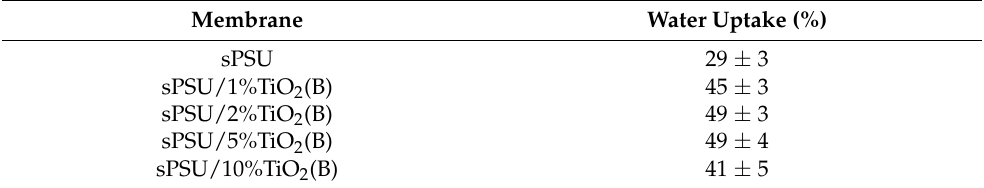
Table 1. Water absorption percentage of sPSU membrane and sPSU/x%TiO 2 (B) composite mem-